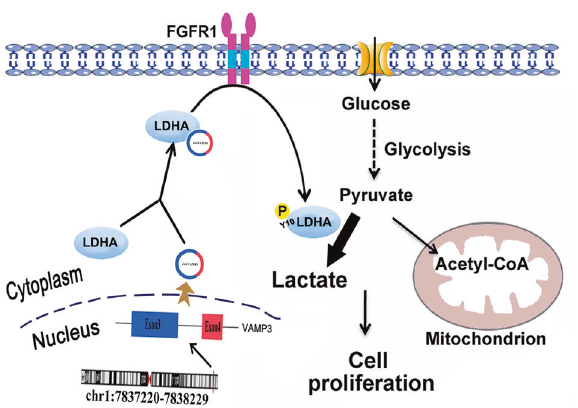
Fig. 8 Graphical abstract of circVAMP3-mediated oncogenic mechanism in RCC progression. The newly identi fi ed circVAMP3 directly binds to LDHA, elevates its Y10 phosphorylation through the upstream kinase FGFR1, and then enhances the enzymatic activity of LDHA, contributing to elevated glycolytic levels and promoting proliferation in RCC